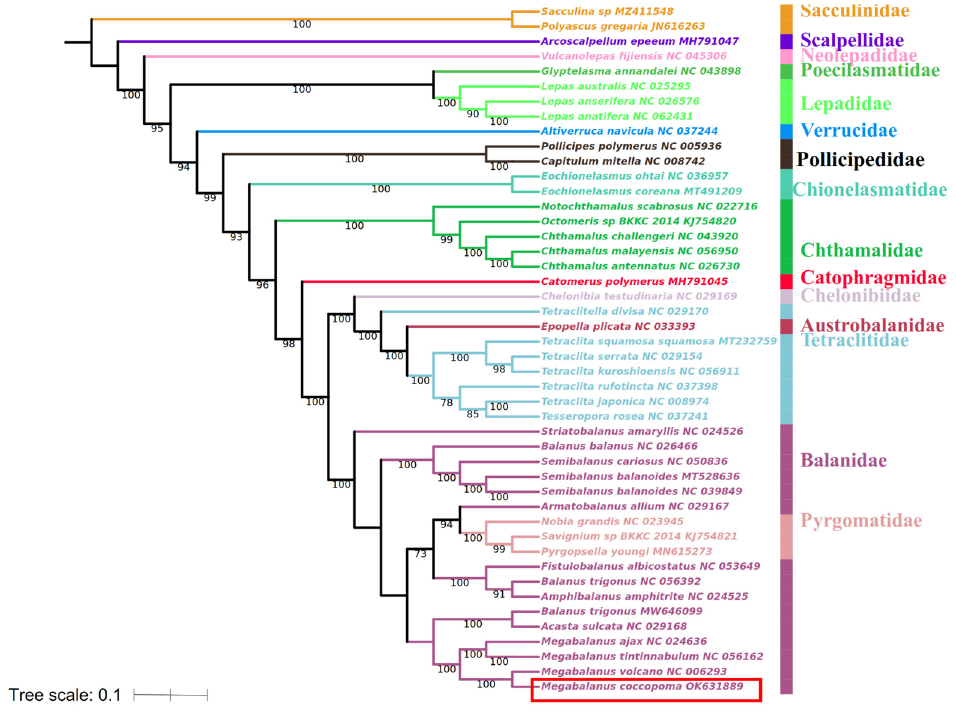
Figure 6. The IQ-Tree is based on 13 PCGs nucleotide sequences of M. coccopoma and other mitochon- drial genomes from 44 Cirripede species. The numbers at the nodes represent the bootstrap values obtained from ML analysis. The IQ-TREE does not take branch length into account. Species in this study are in the red box.